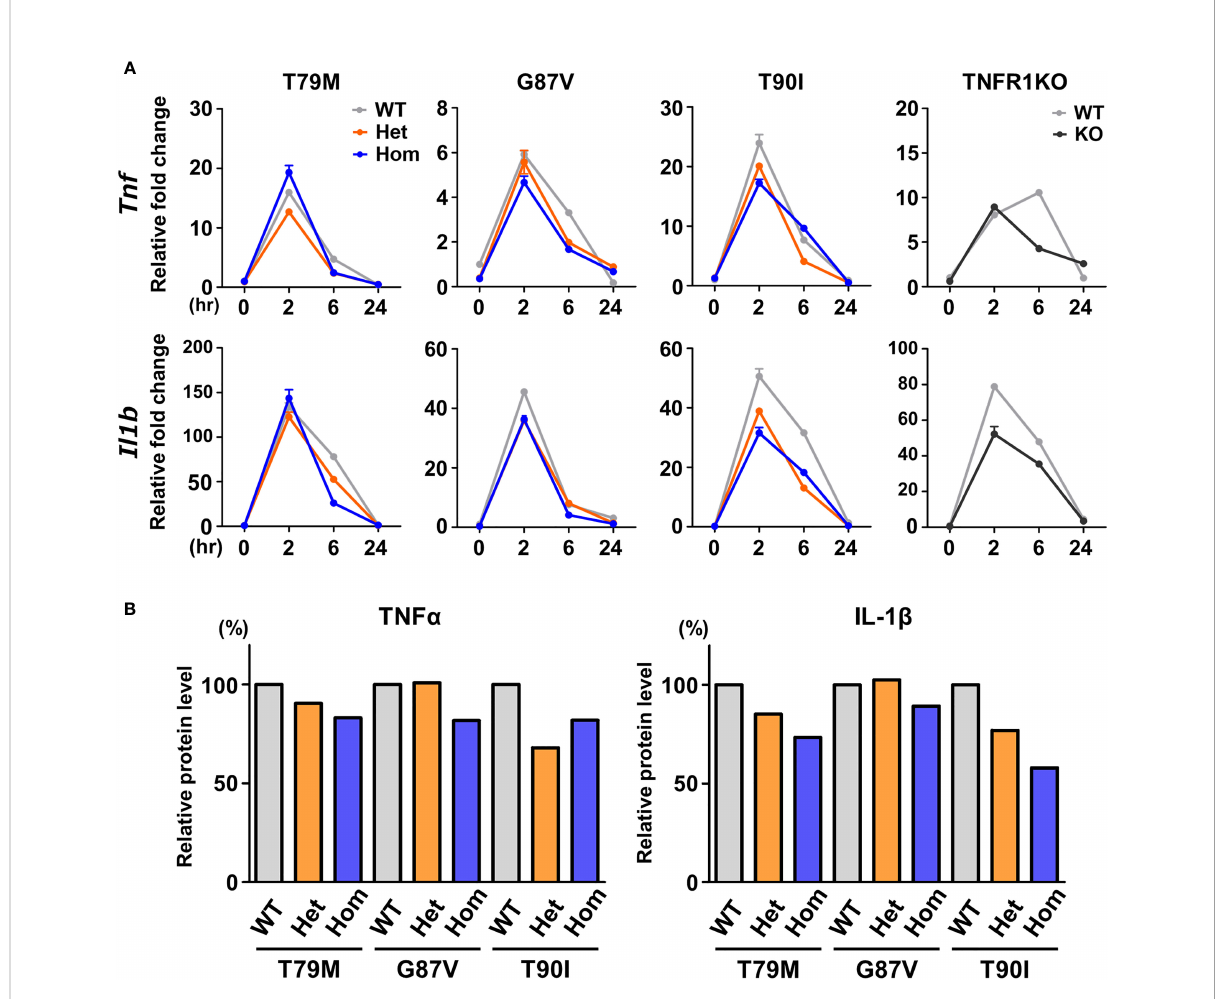
FIGURE 3 No substantial changes in the responsiveness to LPS in the TRAPS mutant macrophages. Bone marrow-derived macrophages were stimulated with LPS (100 ng/mL). After stimulation, the RNA and supernatant samples were collected at the indicated time points. Cell culture experiments were performed separately for each strain. (A) qPCR analysis. The mRNA expression levels of Tnf and Il1b were determined. Gray, orange, blue, and dark gray lines indicate WT, heterozygous, homozygous, and TNFR1KO mice, respectively. (B) Relative protein levels of TNF a and IL-1 b in the culture supernatants. Culture supernatants were collected 6 h after LPS stimulation, and the concentrations of TNF a and IL-1 b were determined by ELISA. Levels were calculated relative to those of the WT in each strain. TNF a , Tumor necrosis factor a ; TRAPS, TNF receptor- associated periodic syndrome; IL, interleukin; LPS, lipopolysaccharide; TNFR1, TNF receptor type I; KO, knockout; qPCR, real-time quantitative polymerase chain reaction; WT, wild-type; Het, heterozygote; Hom,